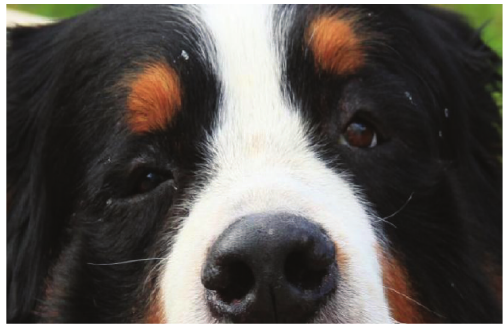
Figure 10: Three-year-old Bernese mountain dog two and a half years after